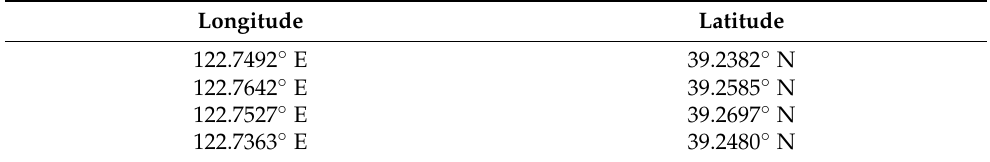
Table 3. Scope of the aquaculture area.